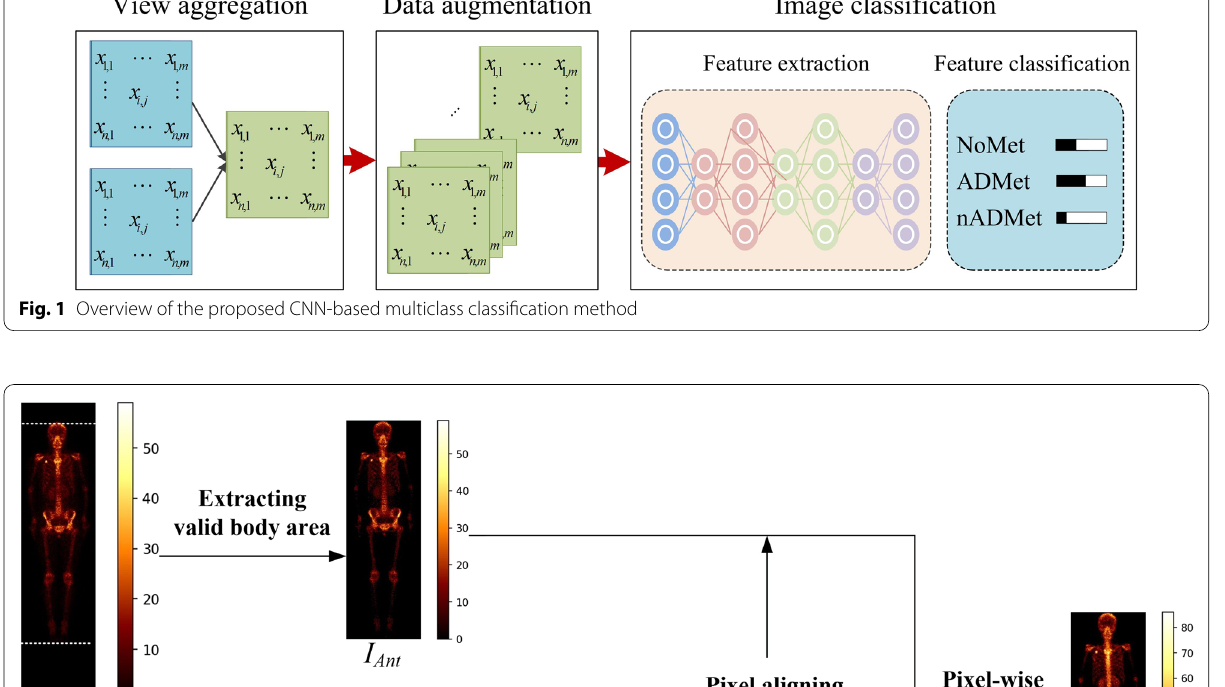
View aggregation During the SPECT imaging, two whole-body images were collected for each patient, corresponding to the anterior- and posteriorviews, respectively. When a pri- mary tumor (e.g., lung cancer) invades into bone tissue, there will be an area of increased radionuclide’s uptake in the image. It is common, however, the metastatic areas have varied intensity of uptake in anterior- and posterior- view images. How to enhance the metastatic areas in images becomes crucial for accurate detection of metas- tasis. A pixel-wise view aggregation method is proposed to ‘excite’ those metastatic pixels, while ‘squeeze’ the nor- mal pixels by fusing two views as shown in Fig. 2.